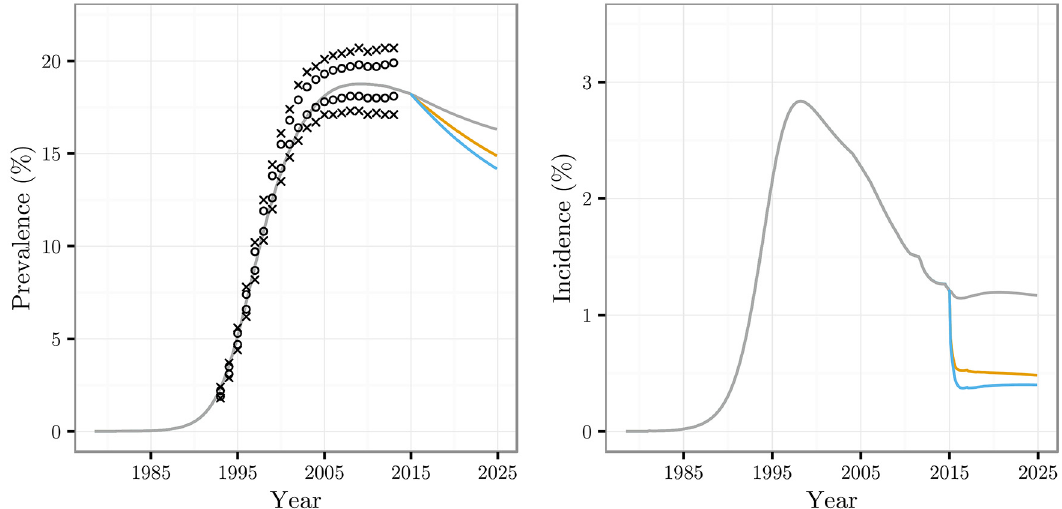
Fig 1. Prevalence and incidence curves. Prevalence and incidence for all three care contexts, for an arbitrarily chosen calibrated epidemiological parameter set. For all parameter sets see Fig C in S1 Supporting Information. The colours correspond to (from top to bottom on both panels): grey — current care (CC) context, orange — enhanced counselling and testing (ECT), blue — universal test and treat (UTT). Also shown on the left panel are the confidence intervals of the UNAIDS prevalence estimates (inner circles) and twice the confidence intervals (outer crosses).